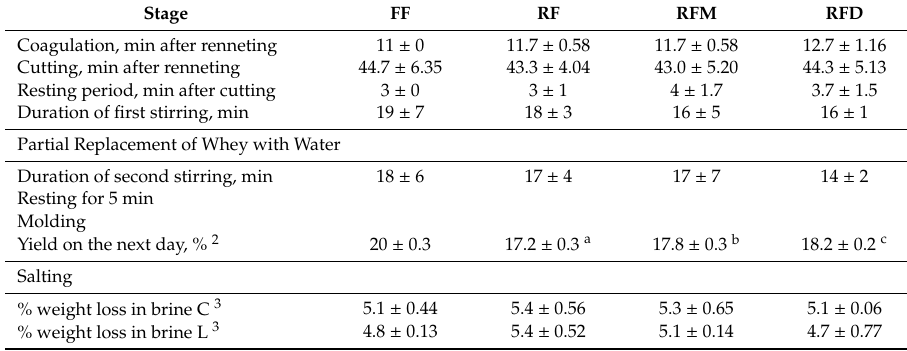
Table 2. Manufacturing conditions of sheep milk semi-hard cheeses considering the addition of rennet as the starting point. The starter was added approximately 10 min before the addition of rennet. Means of three experiments ± standard deviation. Codes are according to Table 1. C: 20% ( w / w ) NaCl brine; L: 20% ( w / w ) NaCl / KCl 1:1 brine.